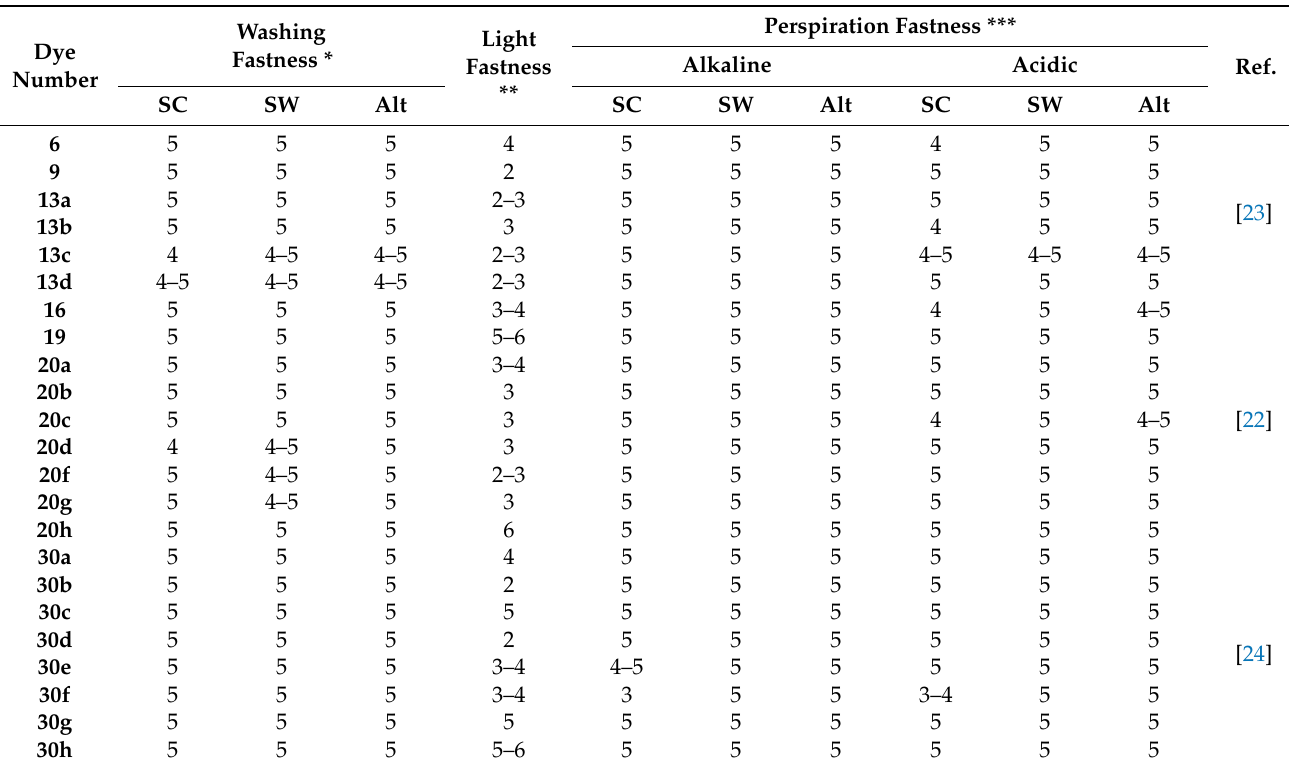
Table 6. Fastness properties of the polyester dyed fabrics with 2% shades of dyes 6 , 9 , 13a – d , 16 , 19 , 20a – h and 30a – h